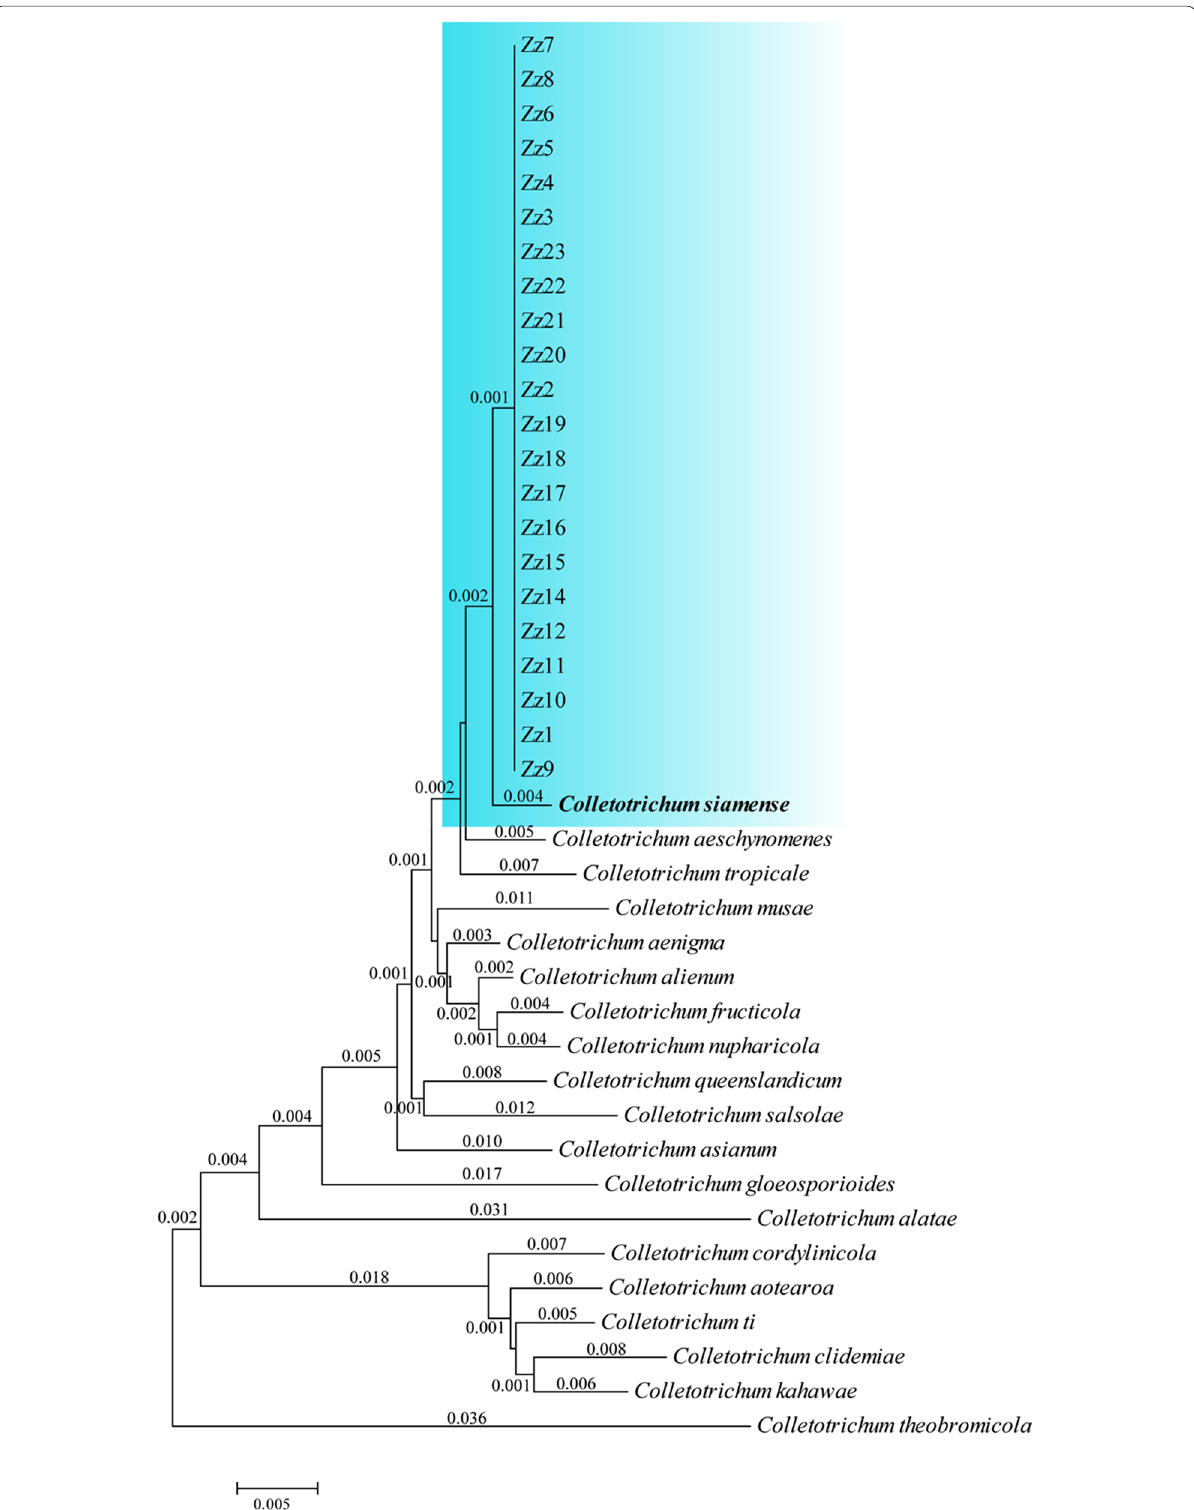
Fig. 1 Phylogenetic analysis of the Colletotrichum isolates from chili based on the combined sequences of ITS, CAL , CHS1 , GAPDH, and ACT . Phylogenetic analysis was performed using MEGA 7 via the neighbor-joining